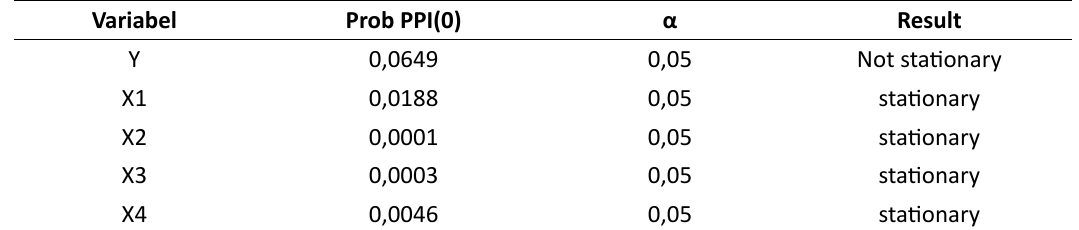
Table 2: Stationary Test Results with the Phillips-Perron Level Test Variabel Prob PPI(0) α Result Y 0,0649 0,05 Not stationary X1 0,0188 0,05 stationary X2 0,0001 0,05 stationary X3 0,0003 0,05 stationary X4 0,0046 0,05 stationary